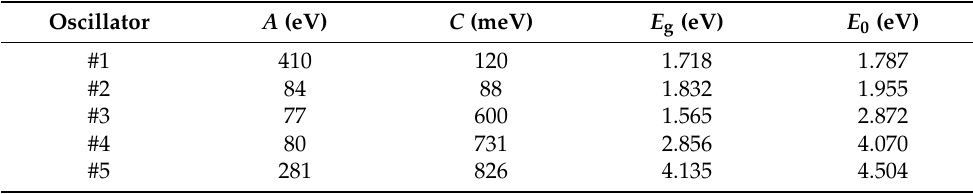
Table 1. Tauc-Lorentz parameters of the oscillators (excitons) with ε ∞ = 0.54 used to describe dielectric function of MBE MoS 2